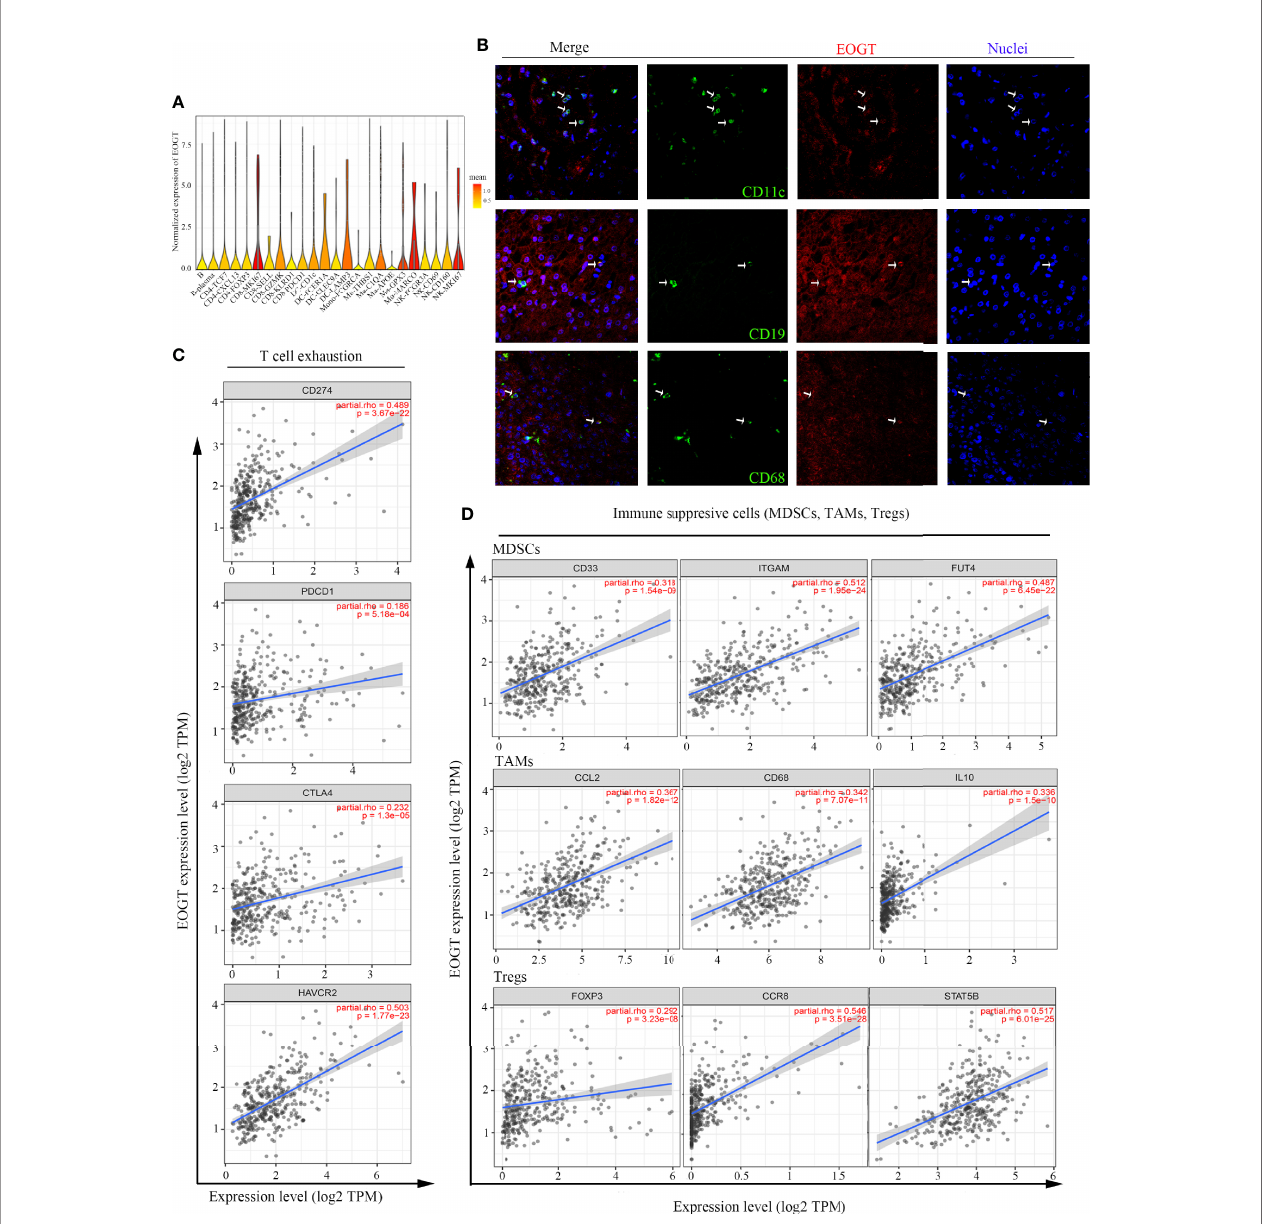
FIGURE 8 | Analysis of immune cell in fi ltration in HCC. (A) EOGT expression was highly expressed on different immune cell subsets according to single-cell RNA- sequencing results of six HCC patients. (B) Immuno fl uorescent staining of EOGT (red), CD11c (green), CD19 (green), CD68 (green), and DAPI (blue) in HCC tissue. (C) Correlations of EOGT expression with immunosuppressive molecules (PD-L1, PD-1, CTLA4, and HAVCR2) involved in T-cell exhaustion. (D) Correlations of EOGT expression with markers of immunosuppressive cells (MDSCs, TAMs, and